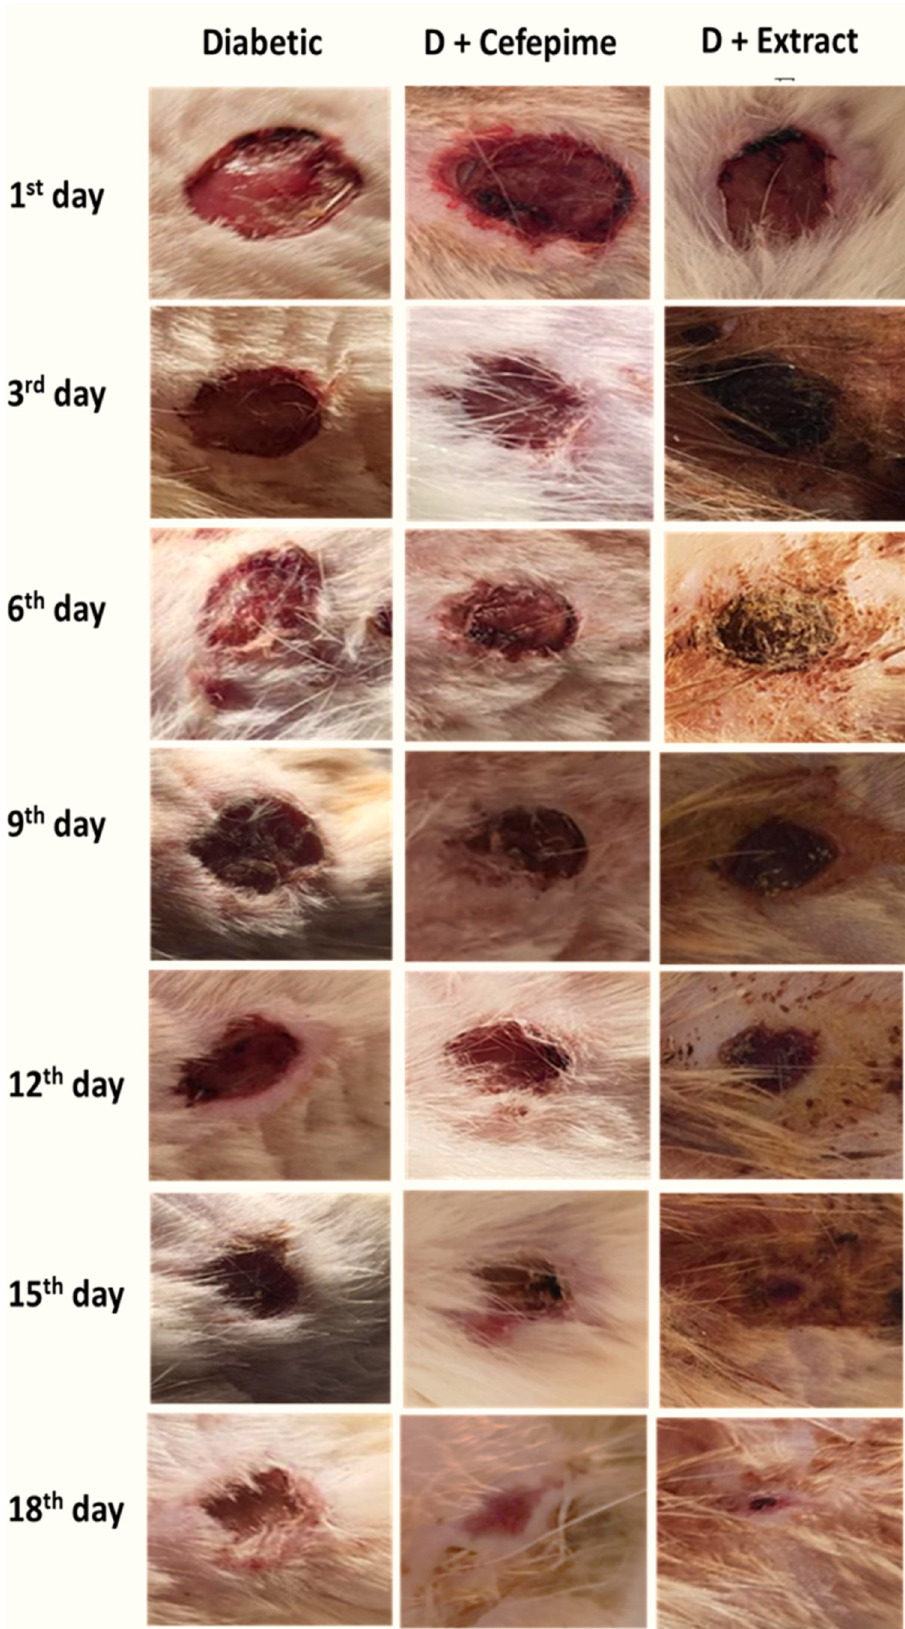
Figure 3. Wound imaging follow-up on the 1st, 3rd, 6th, 9th, 12th, 15th, and 18th days. (three days post diabetic wound curation and infection with P. mirabilis ).